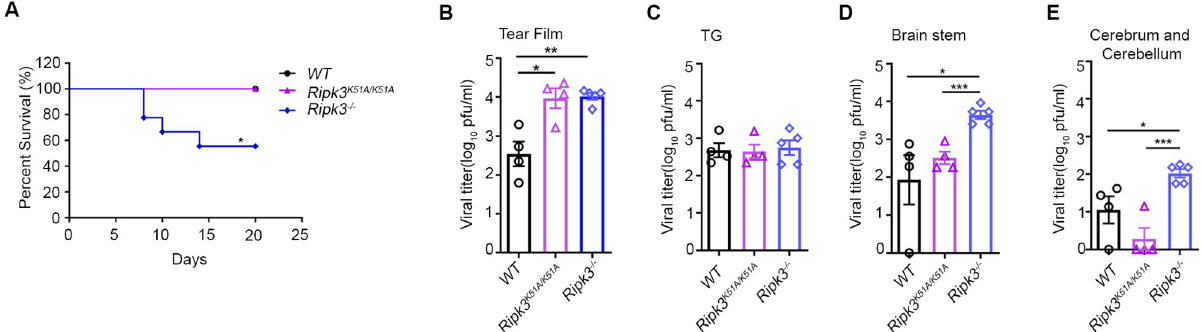
Fig 1. RIPK3 contributes to the pathogenesis of HSV-1 encephalitis, independent of its pro-necroptotic kinase activity. Corneas of 6-8-week-old WT, Ripk3 −/− and Ripk3 K51A/K51A mice were scarified and inoculated with 5 × 10 5 pfu of HSV1 strain McKrae on the left eye. (A) Survival plot showing percent survival of WT (n = 7), Ripk3 −/− (n = 6), and Ripk3 K51A/K51A (n = 9) mice after HSV1 infection. Tear film swab (B), trigeminal ganglion (TG) (C), brainstem (D), and (E) cerebrum and cerebellum tissues were collected at 5 dpi for determining viral titers (n = 4–5 per group). Values are expressed as means ± SEM ( � P < 0.05, �� P < 0.01, ��� P < 0.001).